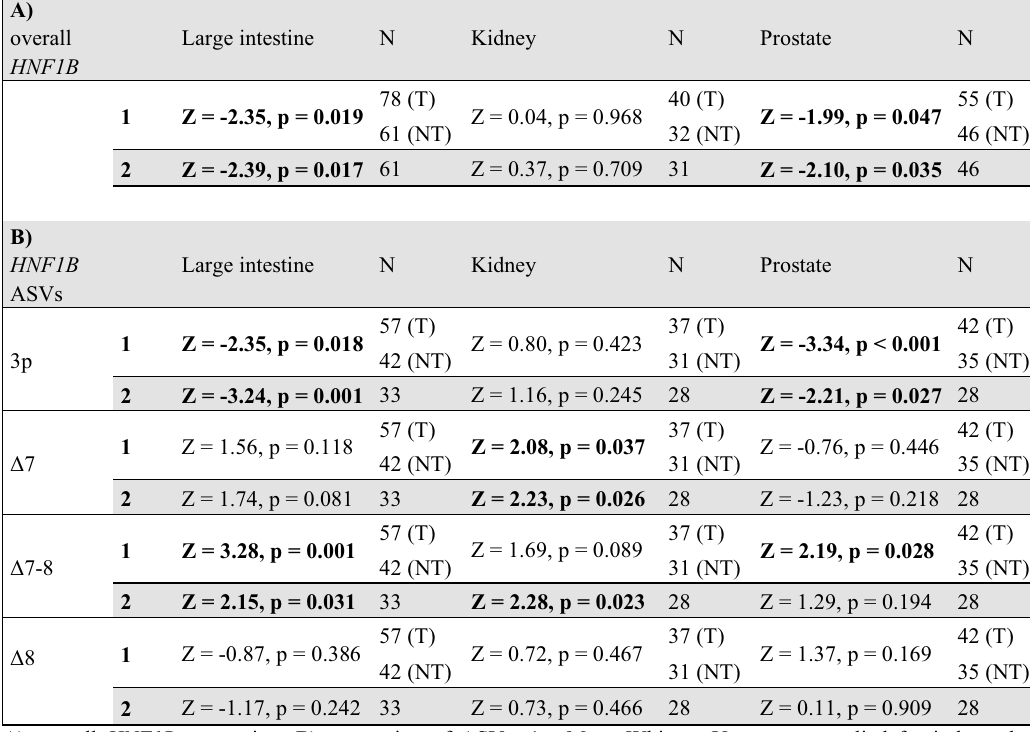
Table 2. Comparison of overall expression or individual ASVs’ expression between tumour and non-tumour samples in different tissues. (A) overall HNF1B expression; (B) expression of ASVs; 1—Mann–Whitney U test was applied for independent samples; 2—Wilcoxon matched-pairs signed-ranks test was used for matched T and NT samples. Statistically significant results are indicated in bold. N number of samples; T tumour tissue, NT non-tumour tissue, Z standardized score, critical value for a 95% confidence interval, p level of marginal significance within statistical